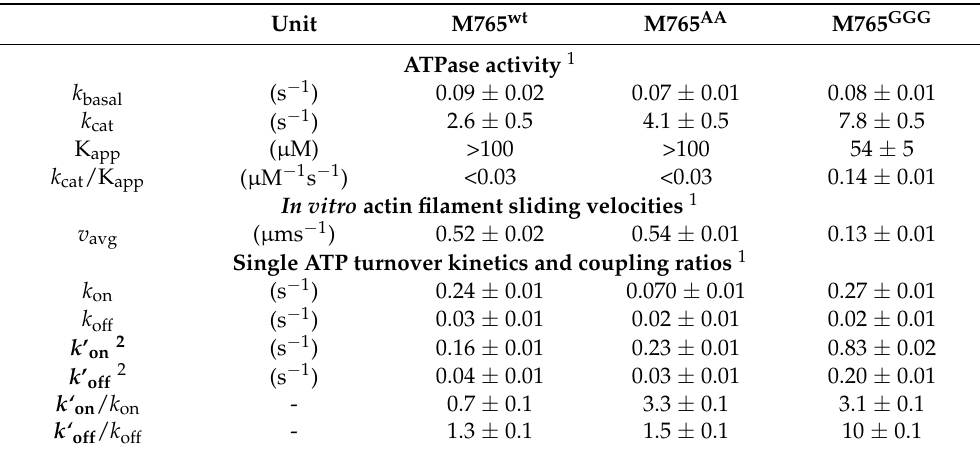
Figure 3. Motor properties, steady-state, and single ATP turnover kinetics. ( a ) ATPase activity of wild-type (M765 wt ) and mutant myosins (M765 AA , M765 GGG ) as a function of actin. Rate constants of maximum ATP turnover ( k cat ) and affinity of myosin for F-actin in the presence of ATP ( K app , i.e., the concentration of F-actin at which the ATPase rate is one-half of k cat ). Parameters were obtained by fitting the data to hyperbolic functions according to Michaelis–Menten kinetics. ( b ) Actin filament translocation in in vitro motility assays. The average sliding velocity (actin translocation speed) for each myosin construct was obtained from Gaussian fits. ( c , d ) Single ATP turnover kinetics in the absence and presence of actin. Normalized fluorescence time traces upon mixing 1 µM myosin with 0.8 µM mATP in the absence ( c ) and presence of 40 µM F-actin ( d ). Table 2. Steady-state ATPase activity, actin translocation velocity, and single nucleotide turnover